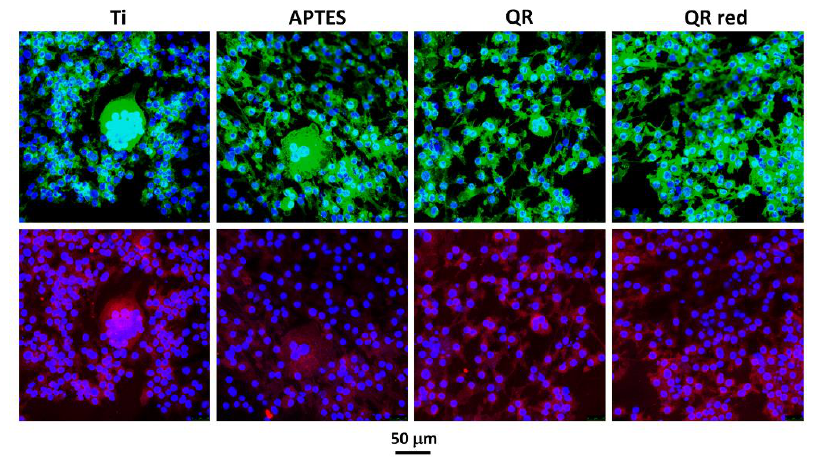
Figure 3. Representative confocal images of multinucleated TRAP (tartrate-resistant acid phosphatase)-positive cells on the different surfaces after 5 days of culture. Cells were stained with Phalloidin-FITC (actin filaments, green), Fluoroshield-DAPI (nucleous, blue) and anti-Trap labeled with Cy3 (Trap protein, red). A higher number of osteoclast-like cells were seen on Ti and APTES surfaces. After seven days of cell culture, the gene expression of phenotypic ( Trap , Calc-R ) and functional